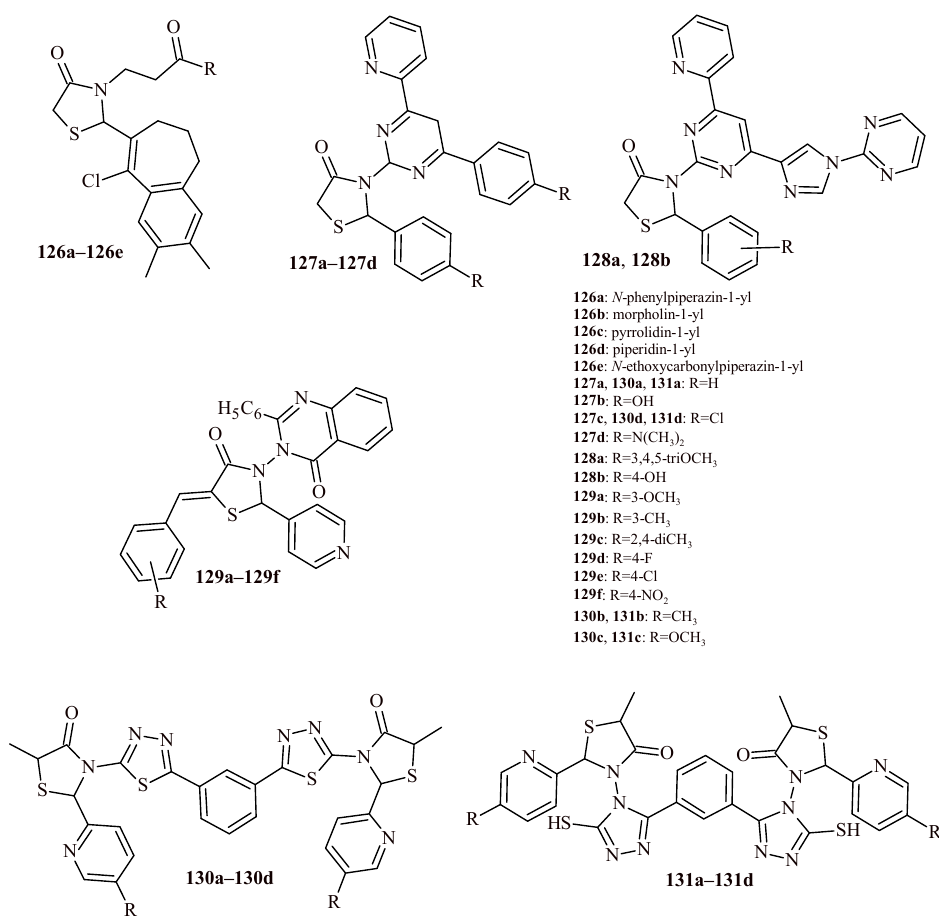
Figure 52. The structures of thiazolidin-4-one derivatives with various heterocyclic substituents in Position 3.